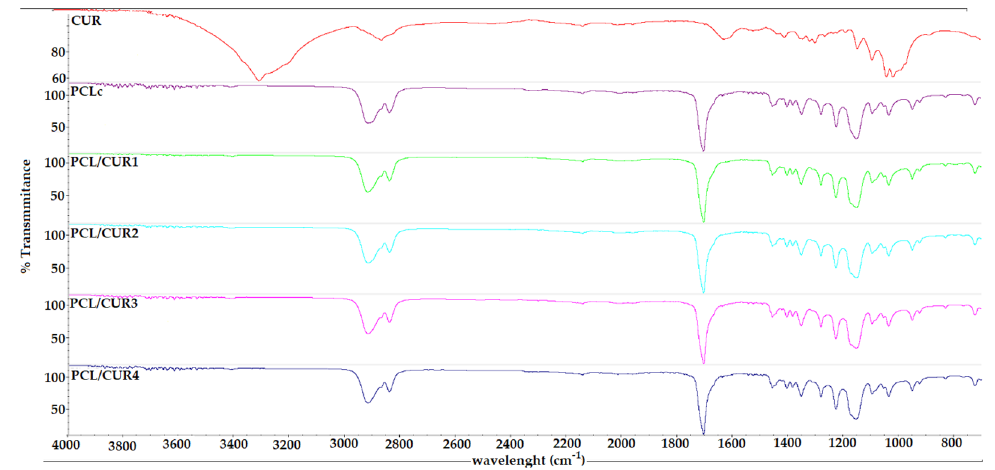
Figure 3. The FTIR spectra of PCL/CUR nanofibers.